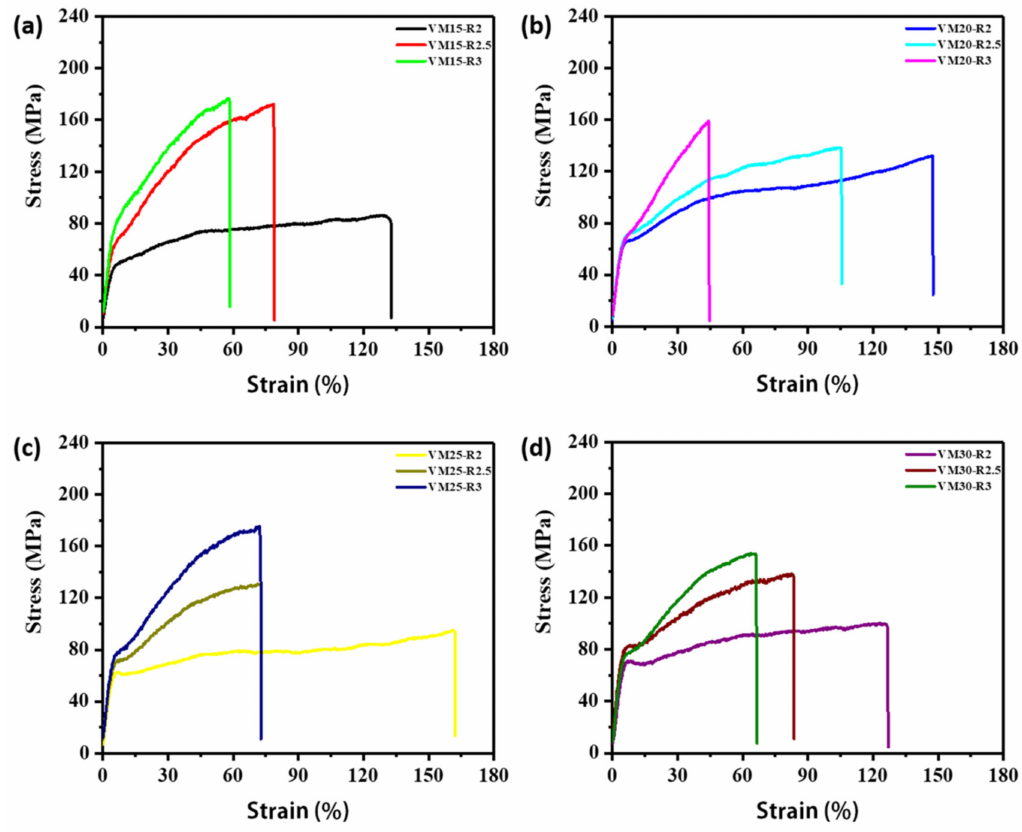
Figure 6. The stress-strain curves of biaxial stretching PVDF/PMMA blend films with varied compositions, ( a ) VM15, ( b ) VM20, ( c ) VM25 and ( d )